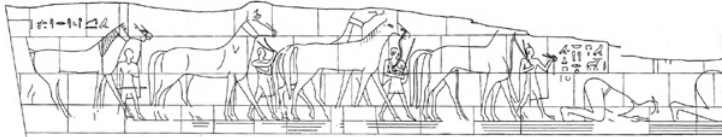
Figure 4 Relief decoration in the courtyard of the Amun Temple at Jebel Barkal showing defeated Egyptian rulers in prostrate positions and a proces- sion of horses led towards Piye, whose figure is partially preserved further to the right, outside the reproduced section of the scene. (Image credit: Tim